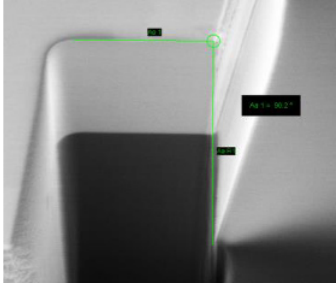
Fig. 6. FIB image of facet showing 90.2 o vertical over 8 µm